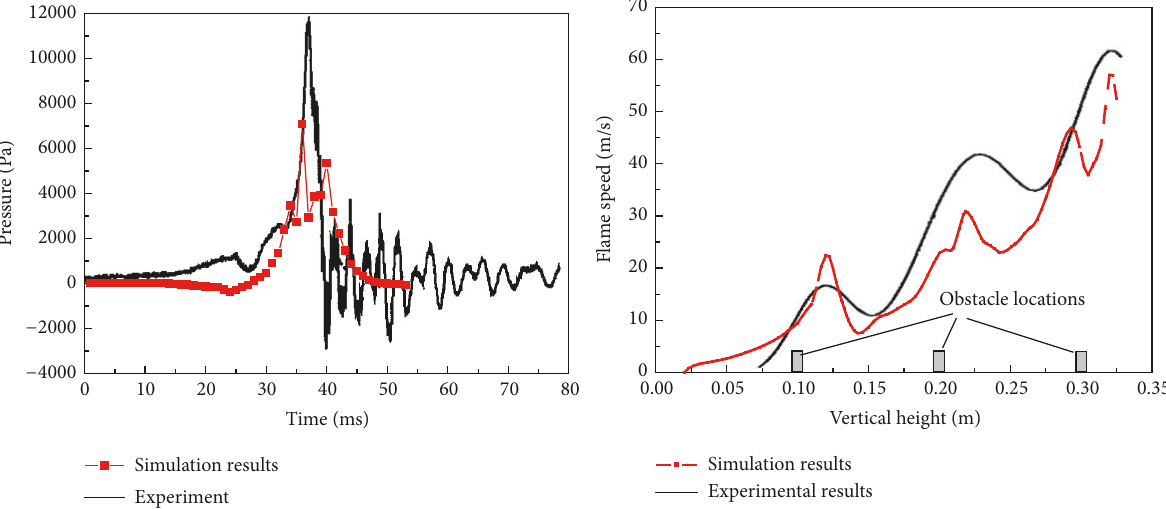
Figure 4: Pressure-time history at the bottom end (left) and flame speed along the combustion chamber length (right).